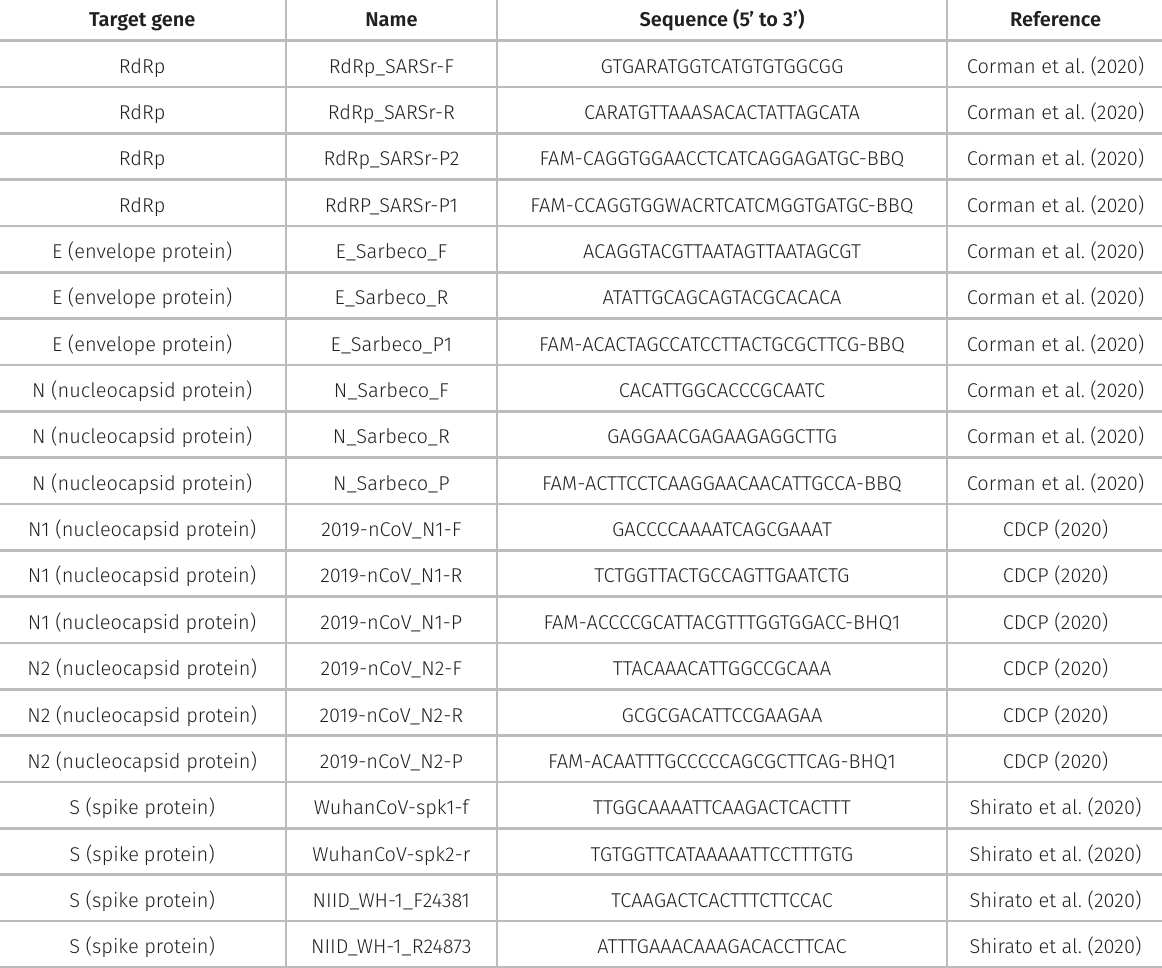
Table II. Main primers and probes used to detect and quantify the SARS-CoV-2 in wastewater. Target